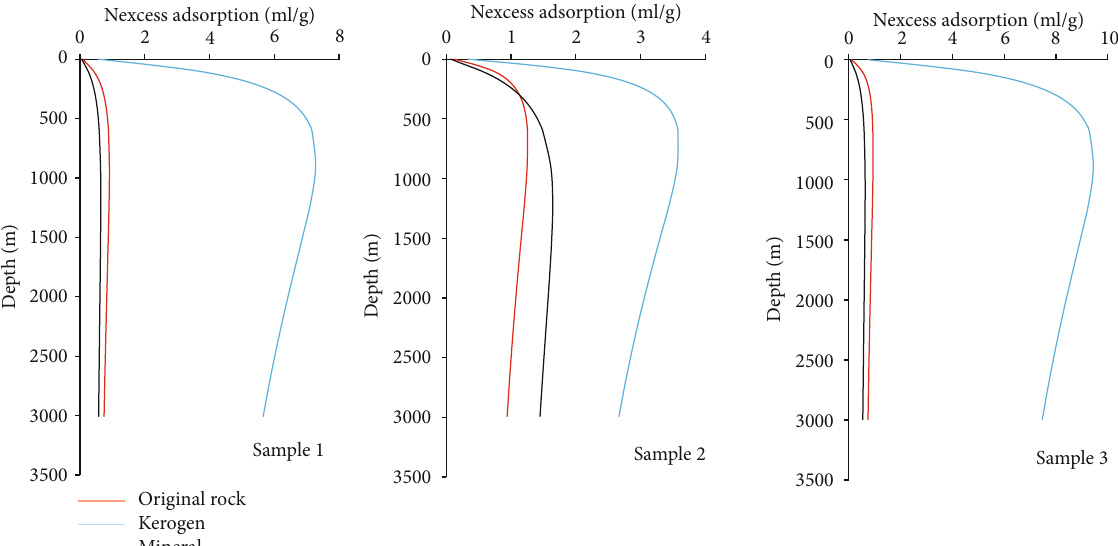
Figure 11: The adsorption capacity of the original rock, kerogen, and mineral composition in three sample under geological